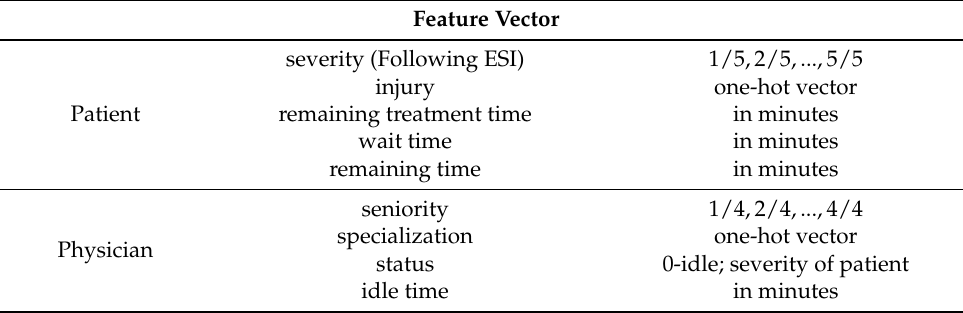
Table 2. Combined patient–physician feature vector.